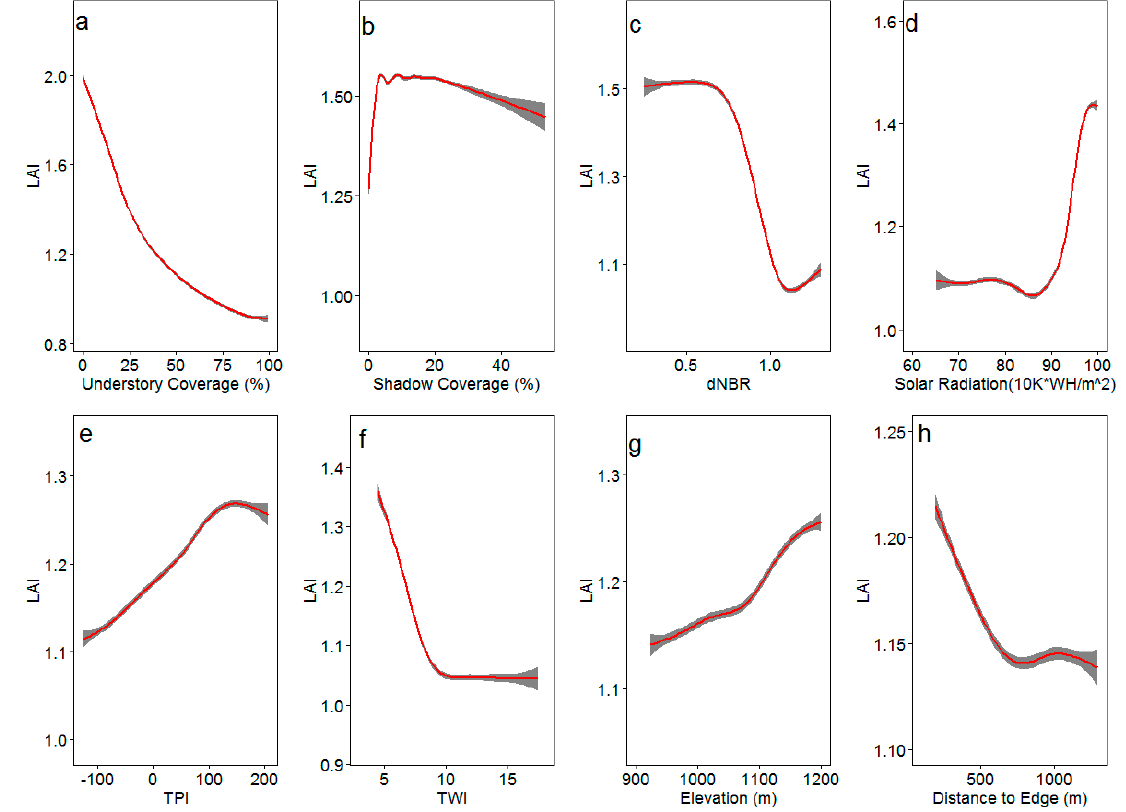
Figure 7. Partial dependence plots of a-h show influences of eight selected spatial controls (variable names see x-axis) on forest recovery in terms of leaf area index (LAI). Variable abbreviations were described in Table 3.